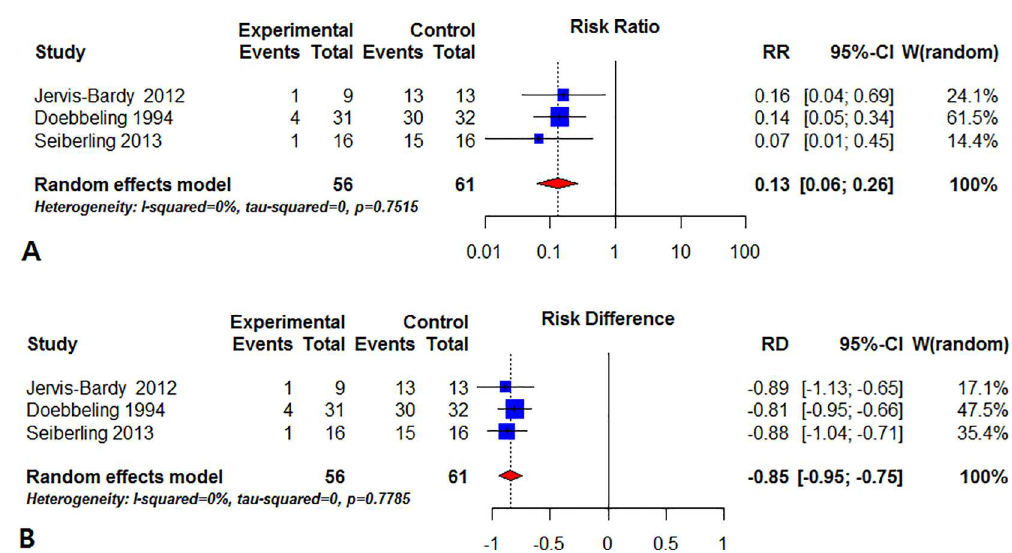
Fig 2. Forest plot of the effect of mupirocin on recalcitrant CRS. (A) The pooledrelative risk (RR) of 0.13 was calculatedusing the inverse variancemethod and random effects model. (B) The pooledrisk difference was calculatedto be